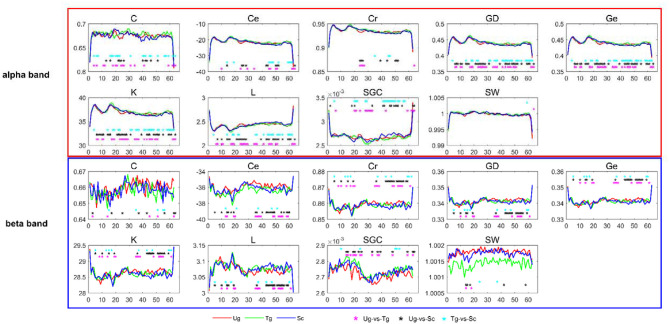
T-tests of brain network metrics. The red, green, and blue curves denote the values of the metrics under the Ug, Tg, and Sc conditions, respectively. The cyan, black and magenta “*” symbols denote significant differences determined by t-tests (p < 0.05) for the Tg-vs-Sc, Ug-vs-Sc, and Ug-vs-Tg paired intentions, respectively. The horizontal and vertical axes represent the time window number and graph metric value, respectively.